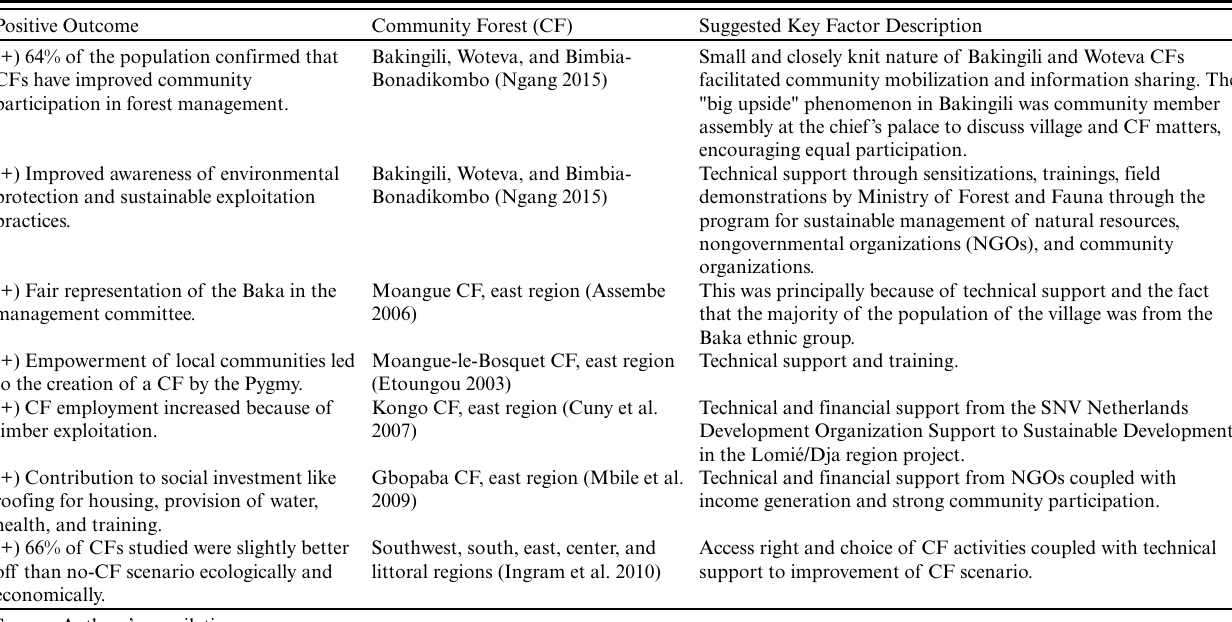
Table 10 . Key drivers of positive outcomes from specific case studies. Positive Outcome Community Forest (CF) Suggested Key Factor